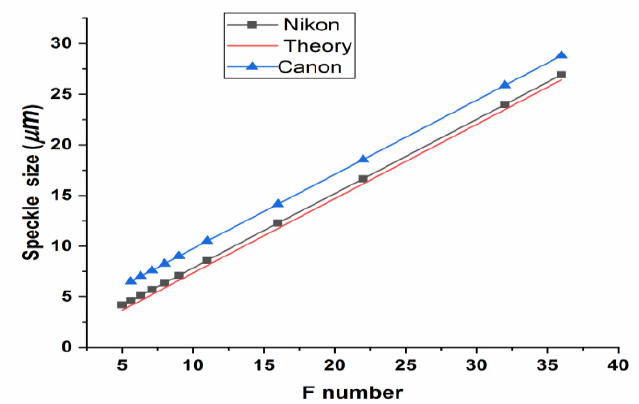
Figure 2. Observed average speckle size, as a function of F -number for the two DSLR cameras. The red line indicates the theoretical speckle size.